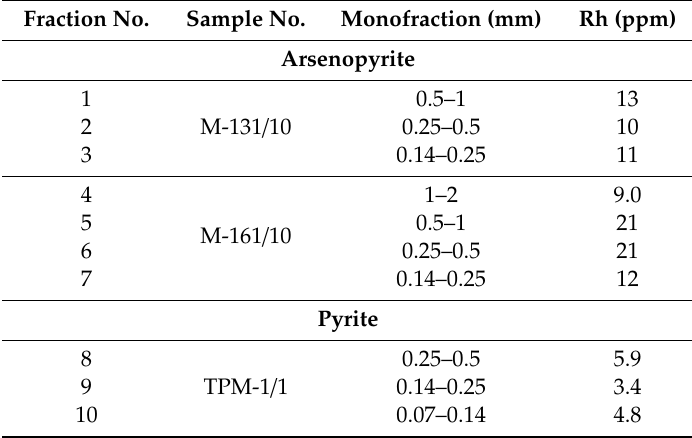
Table 2. The content of rhodium in the differently sized monofractions of arsenopyrite and pyrite selected from vein and streaky-vein ores of the Natalkinskoe deposit.